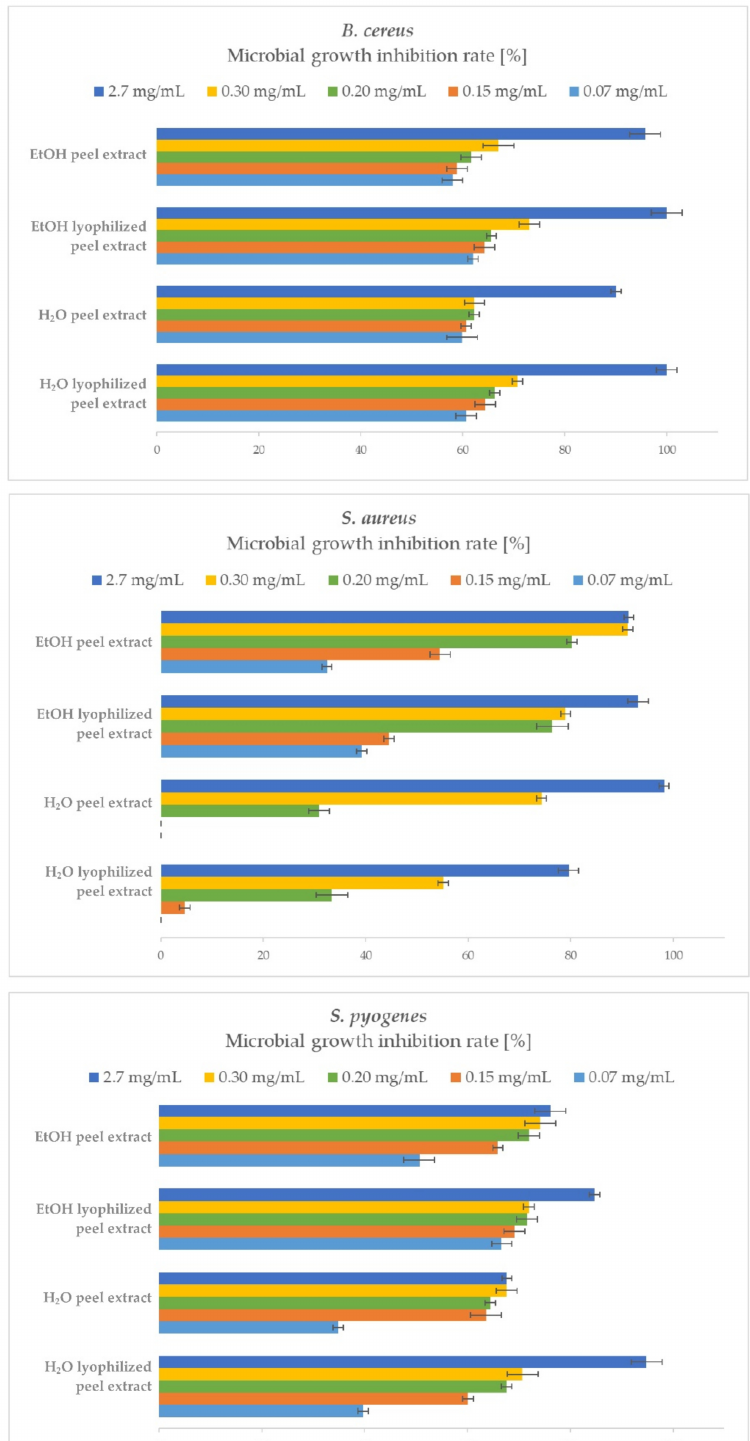
Figure 3. Microbial growth inhibition rates (MGIRs) for P. granatum extracts using 2.7, 0.3, 0.2, 0.15, and 0.07 mg of sample/mL of B. cereus , S. aureus , and S. pyogenes suspension. Initial concentrations of microorganisms were 1–5 × 10 6